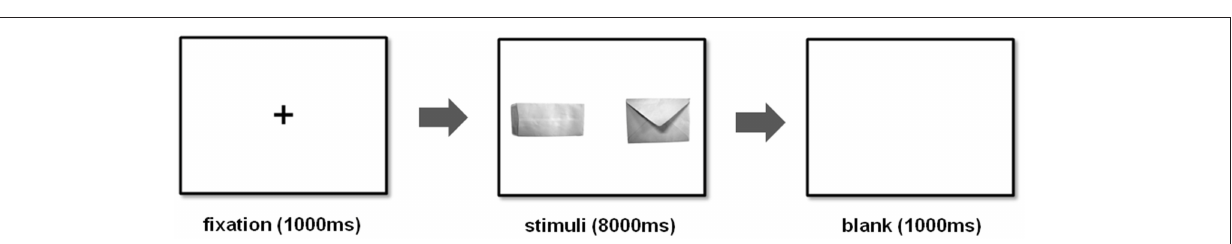
Frontiers in Psychiatry |